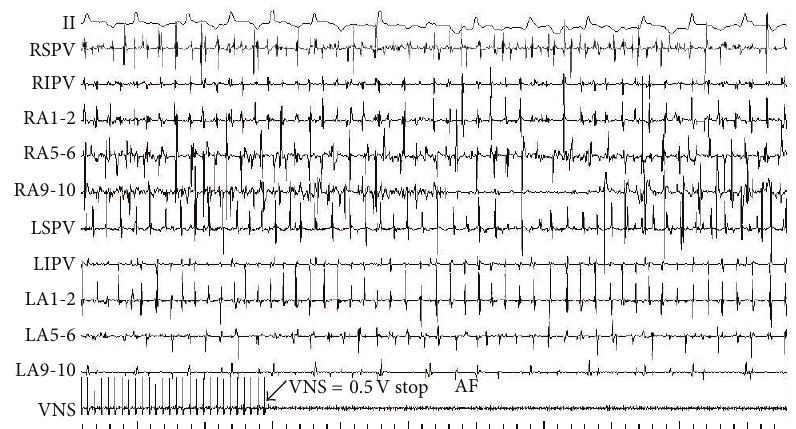
Figure 8: VNS maintained AF. The AF was persistent during VNS with the voltage at 0.5 V. While the VNS was removed, AF still maintained. AF: atrial fibrillation.